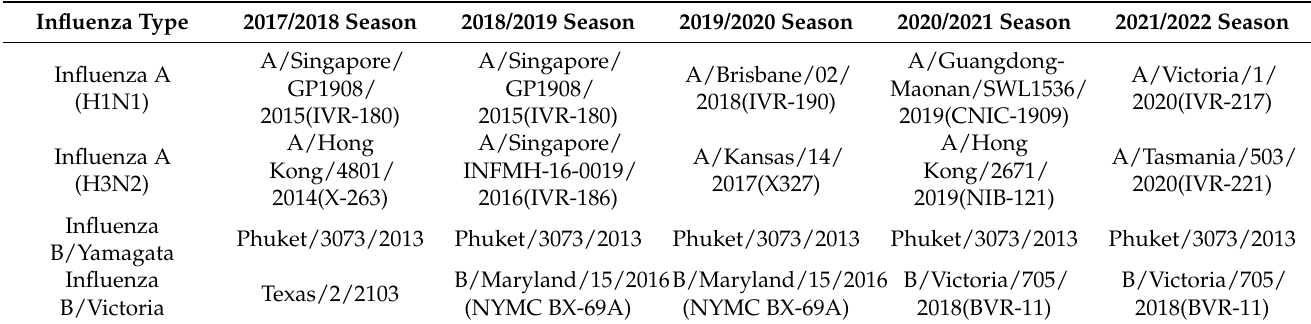
Table 1. Strains used for influenza vaccines in Japan according to